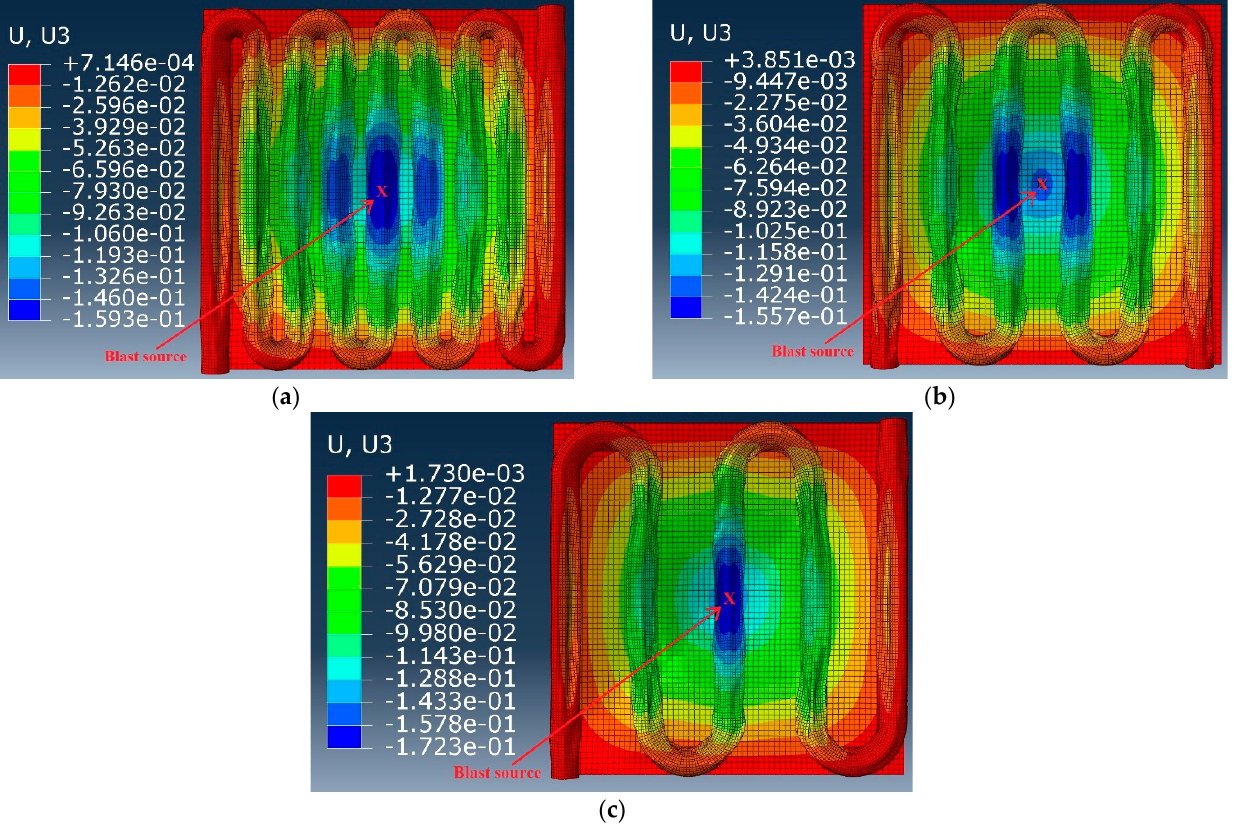
Figure 21. Blast load location of the tubular shape—top view ( a ) D = 75 mm ( b ) D = 112.5 mm ( c ) D = 150 mm.